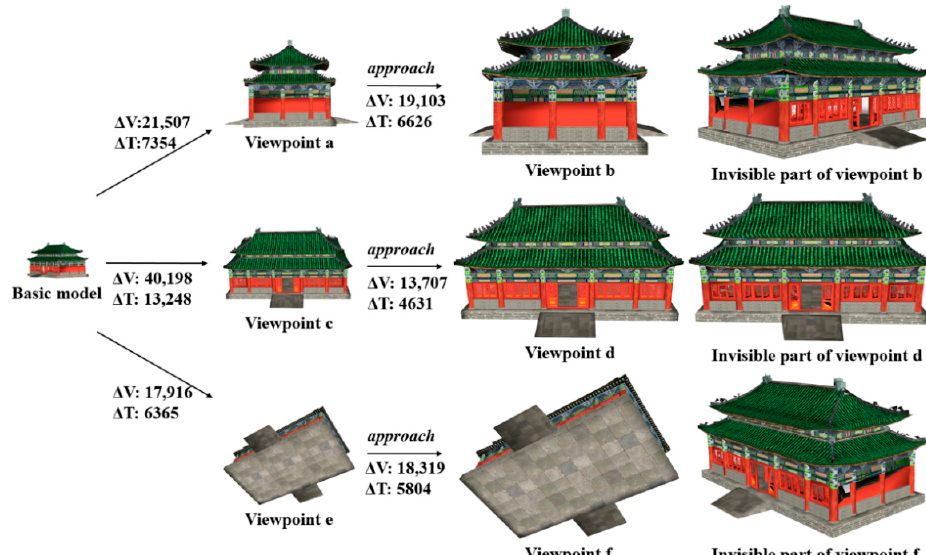
Figure 10. View-dependent effect of single complex building.